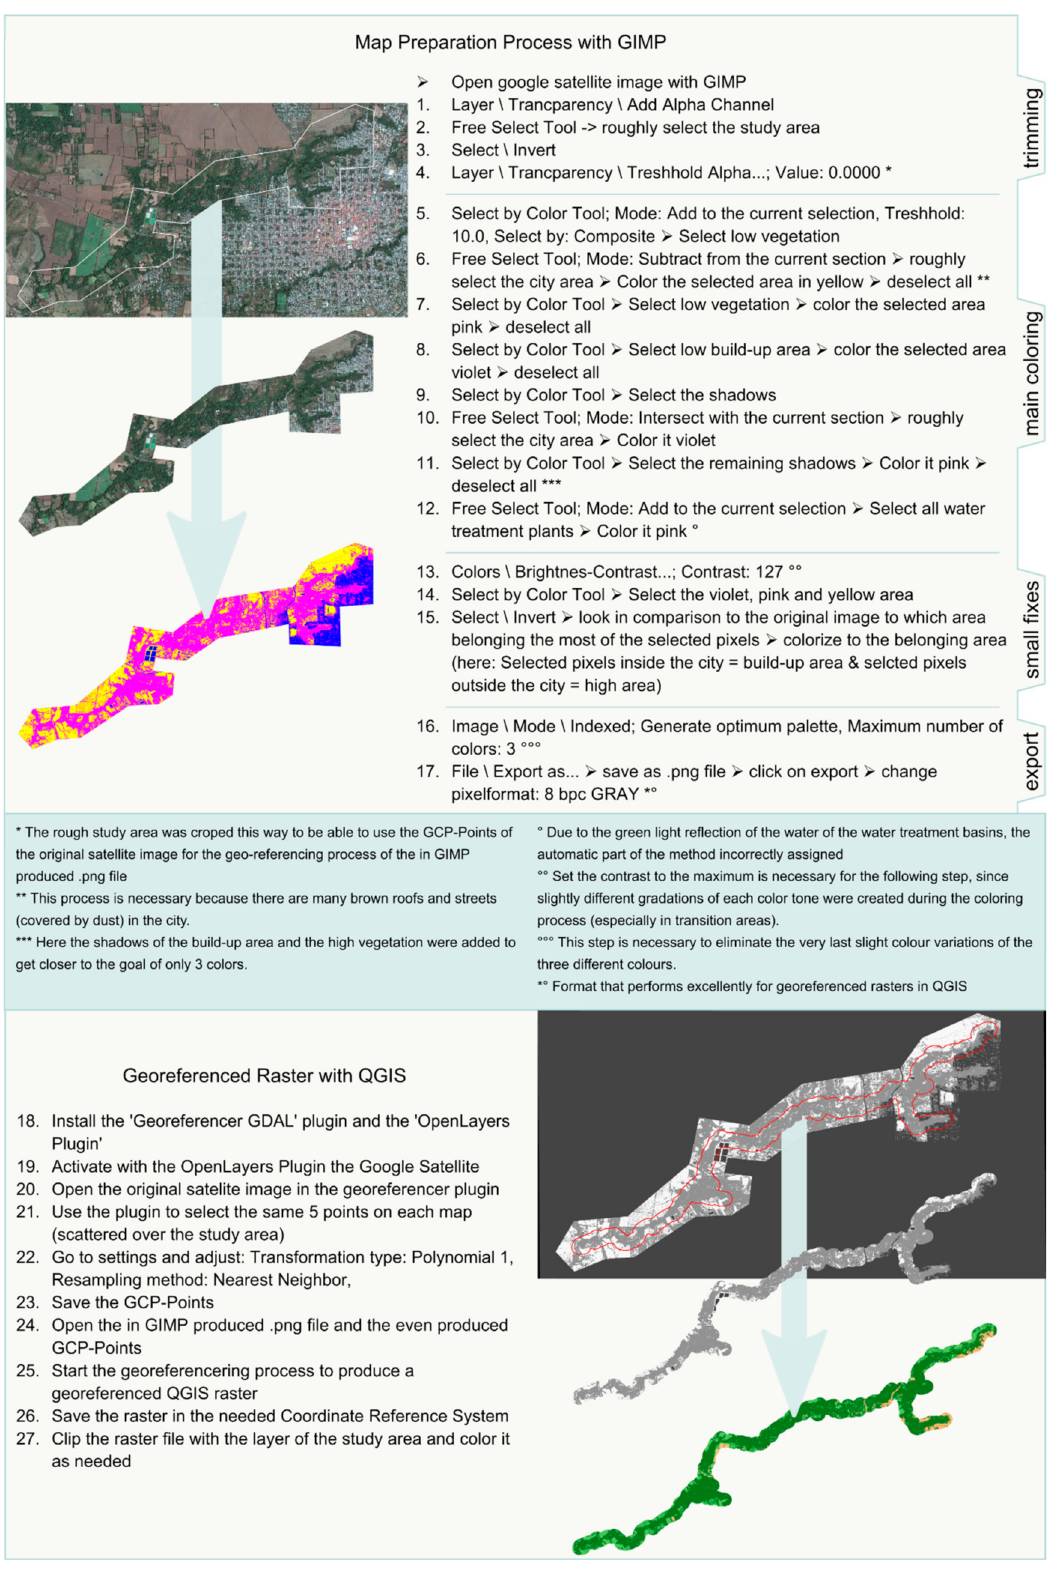
Figure A2. Manual of producing a land cover map with the software GNU Image Manipulation Program (GIMP) and the geoinformation software